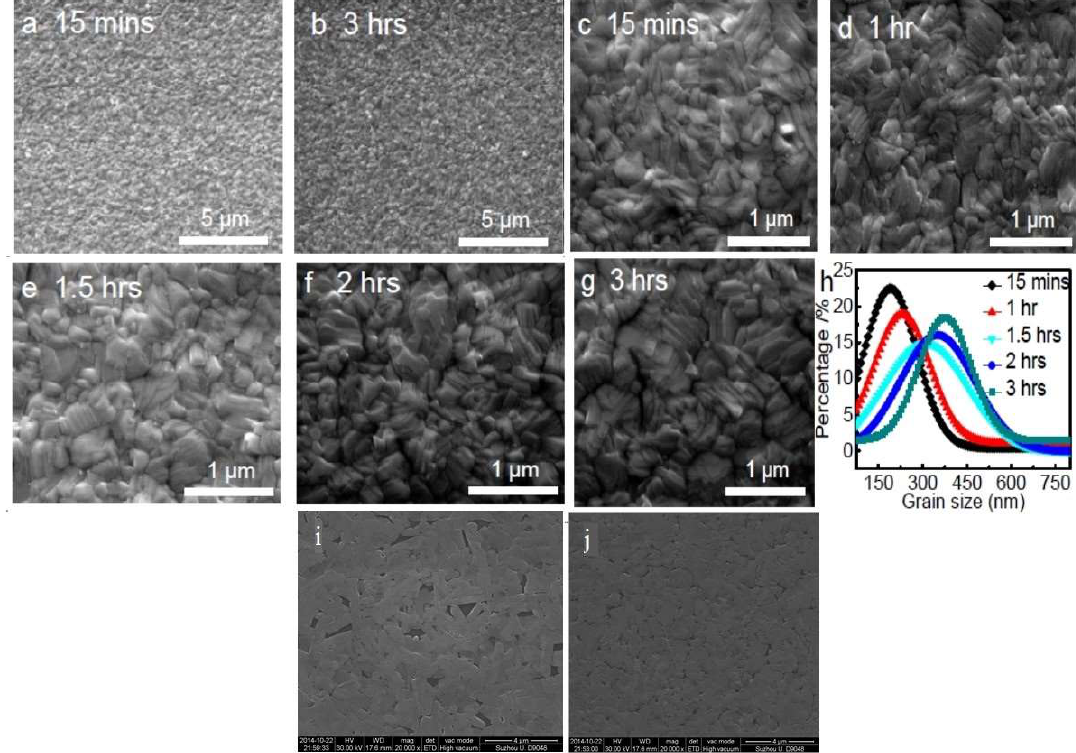
Figure 5. SEM images of perovskite films at di ff erent annealing times and scale bars from ( a – g ), ( h ) Grain size of the perovskite films at di ff erent annealing times, ( i ) One-step annealed and ( j ) two-step annealed MAPbI 3− x Cl x perovskite films on ITO/PEDOT:PSS surface, respectively.